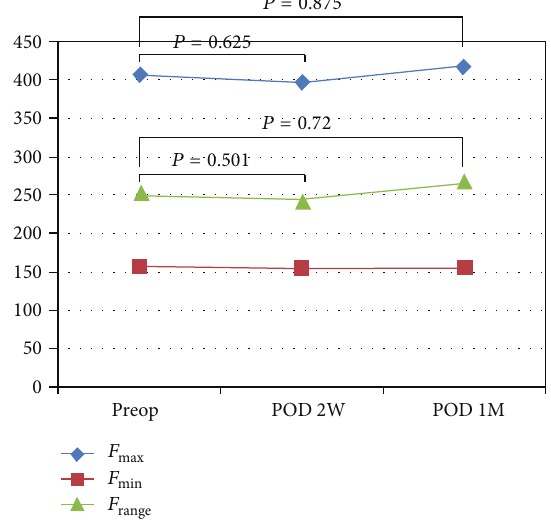
Figure 3: Mean value of frequency in group B. 𝐹 max , maximum frequency; 𝐹 min , minimum frequency; 𝐹 , range of frequency; range Preop, preoperative; POD, postoperative day; 2W, 2 weeks; and 1M, 1